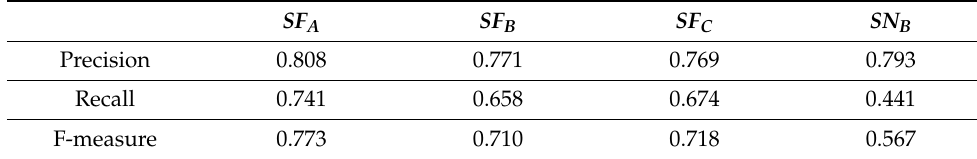
Table 2. Comparison of the delamination detection results.